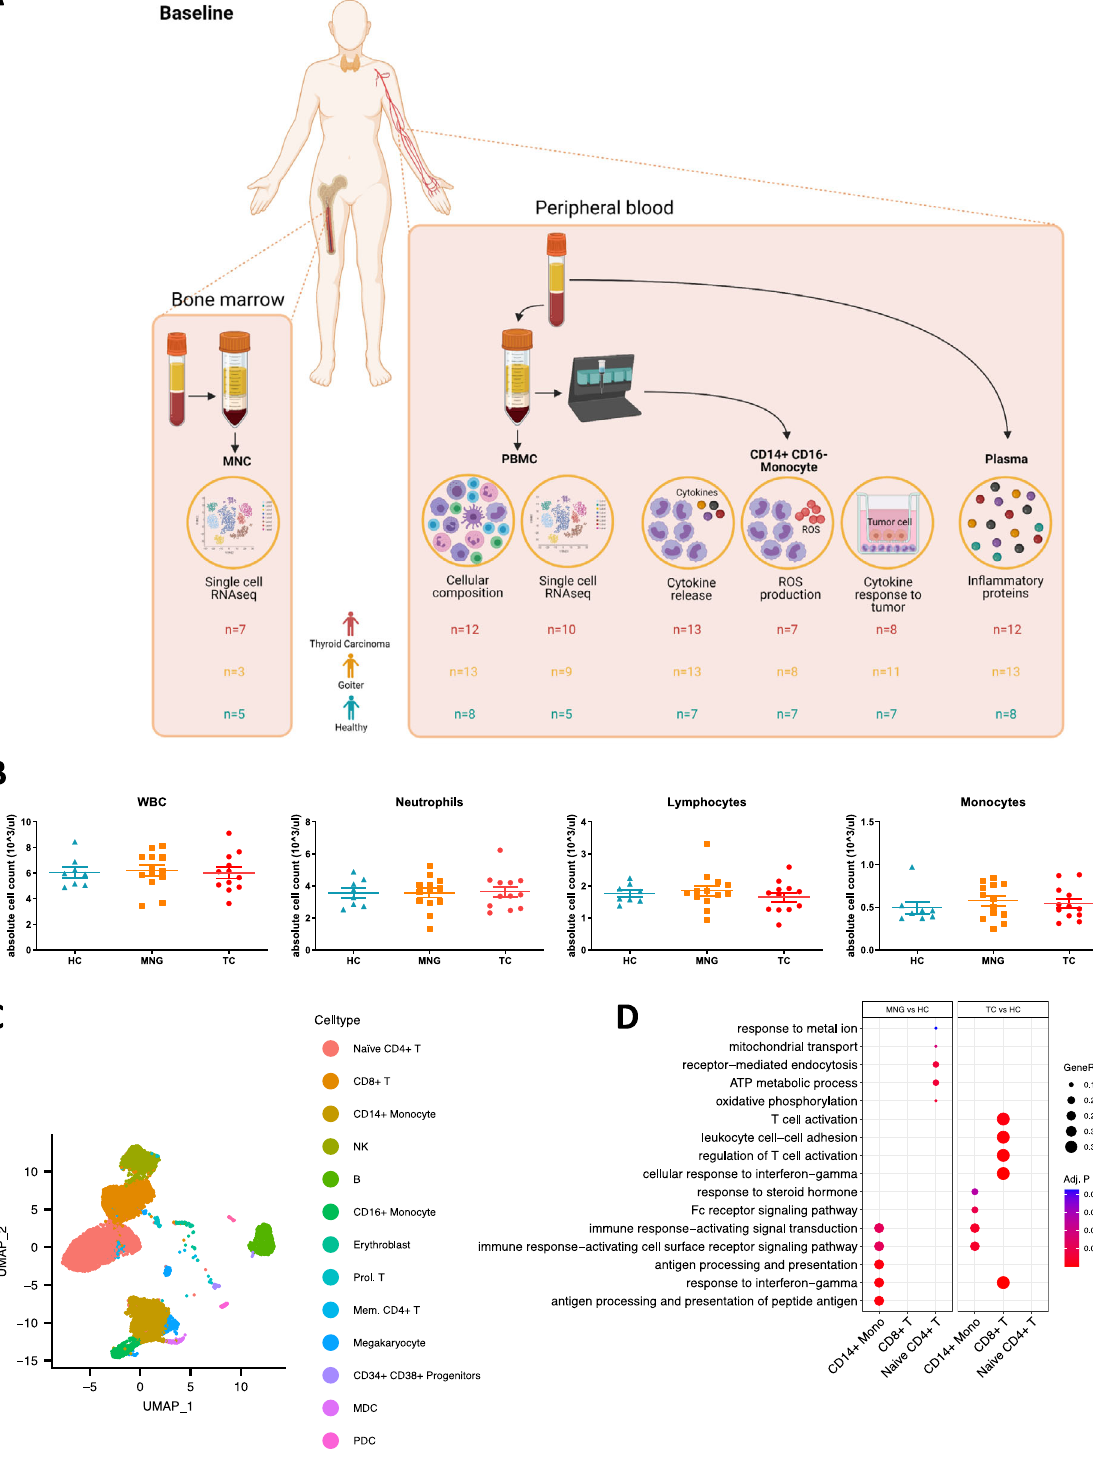
Fig. 1 | Graphical outline of study design and cell counts and single-cell tran- scriptomics of peripheral blood mononuclear cells. A Study Design Baseline Measurements: Bone marrow and Peripheral blood were collected from Thyroid carcinoma(TC)patients,MultinodularGoiter(MNG)patientsandHealthyControls (HC). Illustration created with BioRender.com. B Box plot of cell counts in whole blood. (HC n =8,MNG n =13, TC n =12) Mean±SEM. One-wayANOVAfollowed by Bonferroni post hoc correction. C UMAP projection of the 16,161 PBMC-derived